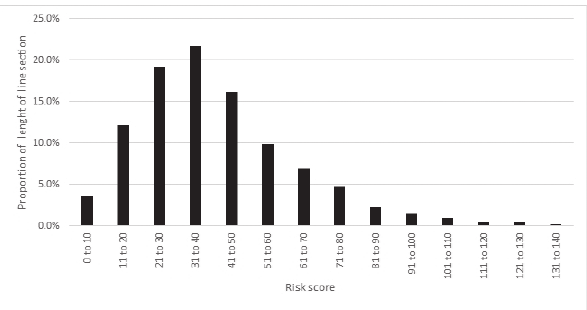
Figure 3. Frequency distribution of grouped risk scores for the total length of overhead line spans (for the whole of